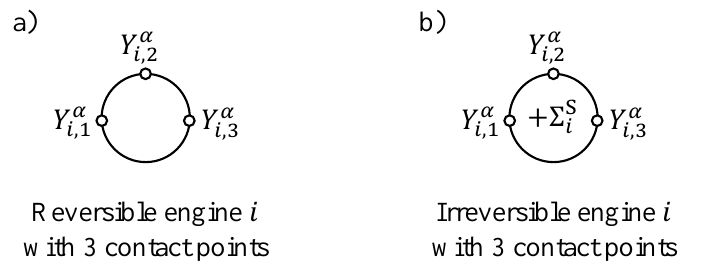
Figure 2. Schematics of engines, here illustrated with three contact points.